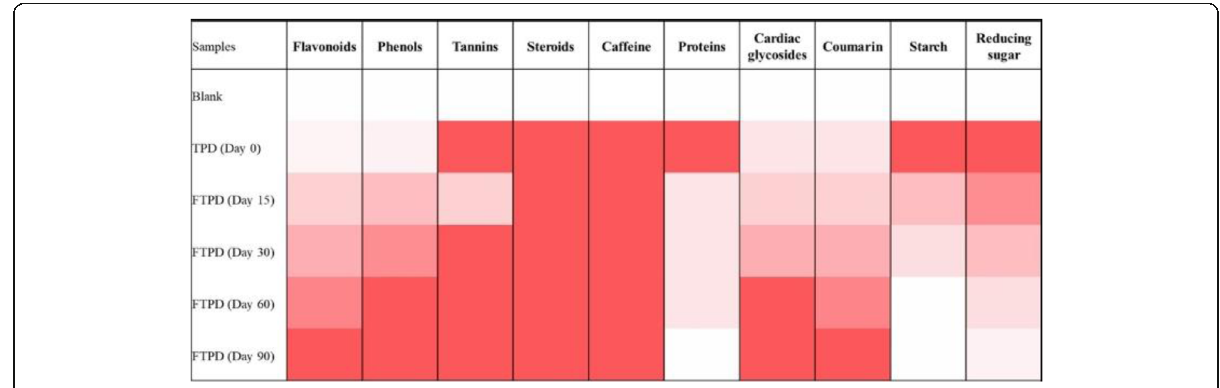
Fig. 2 Heatmap showing levels of different qualities, tested on TPD and FTPD samples (taken at different stages of